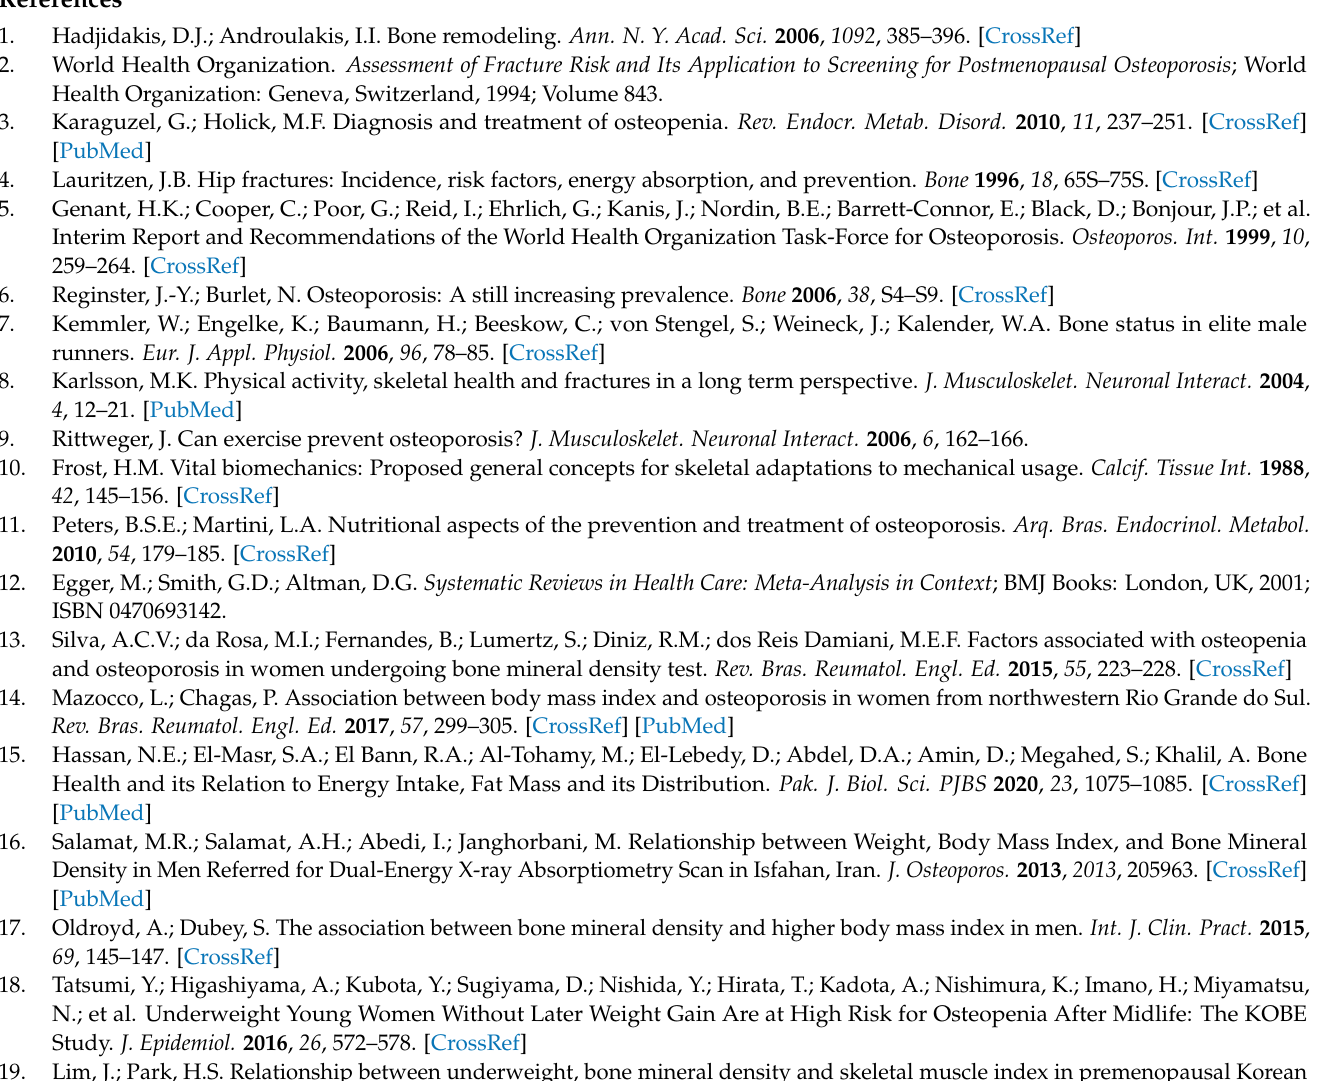
Water supplementation and bone, Table S23a: Caffeine intake and bone, Table S23b: Caffeine sup- plementation and bone, Table S24: Salt intake and bone, Table S25: Isoflavones supplementation and